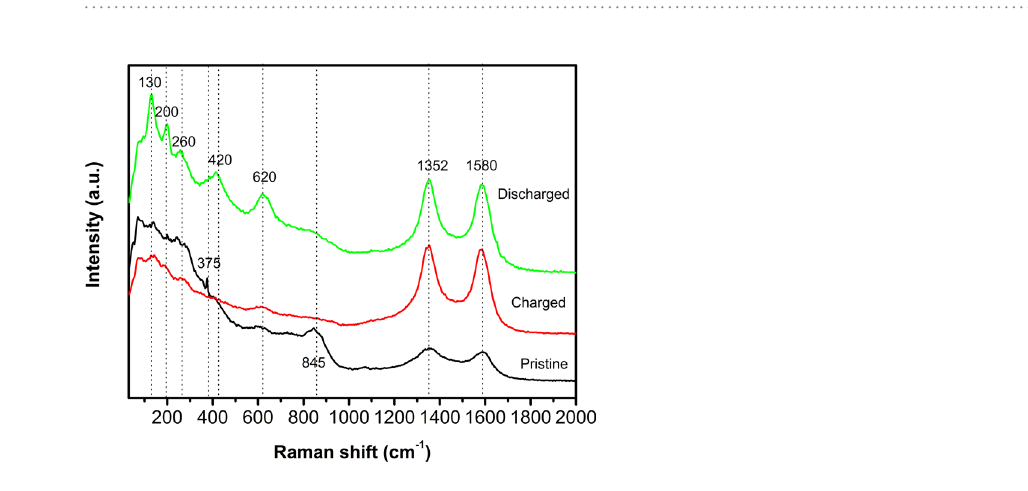
Figure 4. Long-term cycling of Na 2 Ti 0.94 Cr 0.06 O 2.97 at current density of 378 mA g − 1 .